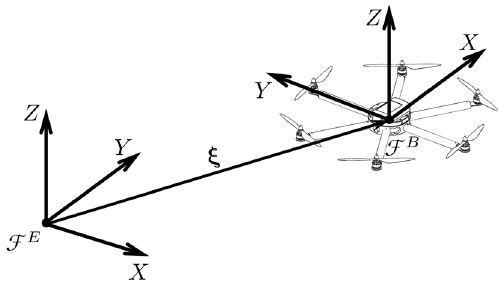
Figure 1. Multirotor unmanned aerial vehicle (UAV) reference coordinate systems.